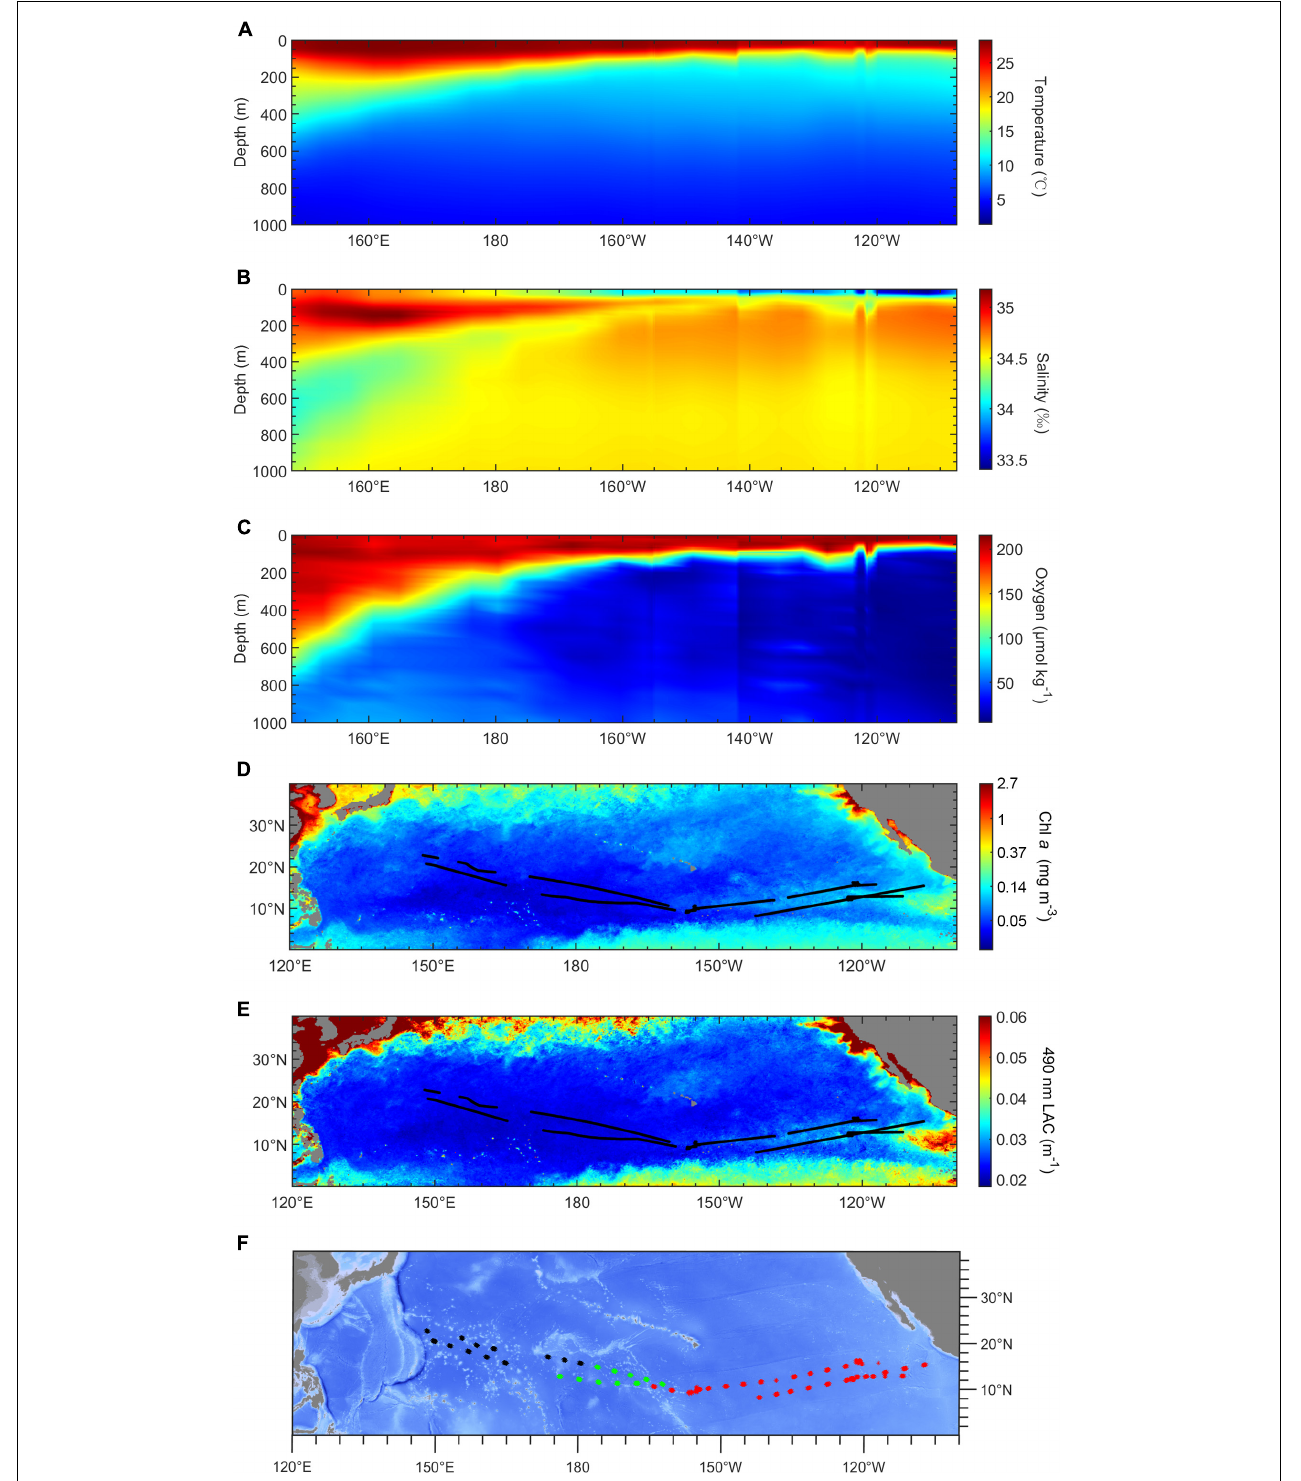
), and oxygen concentration ( µ mol kg - 1 ) in acoustic transects (cid:104)